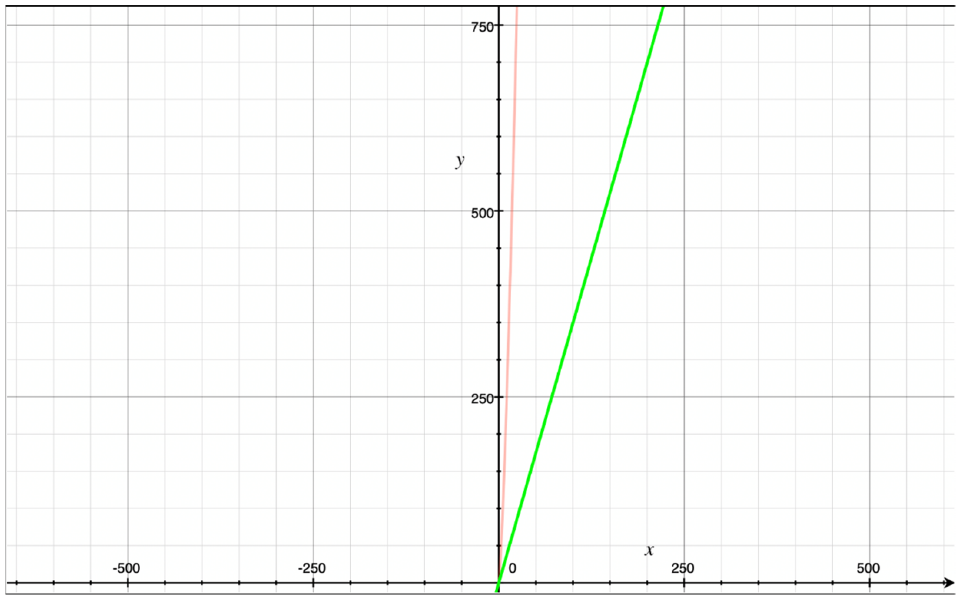
Figure 12. Complexity of Median and Kalman filter implementation.